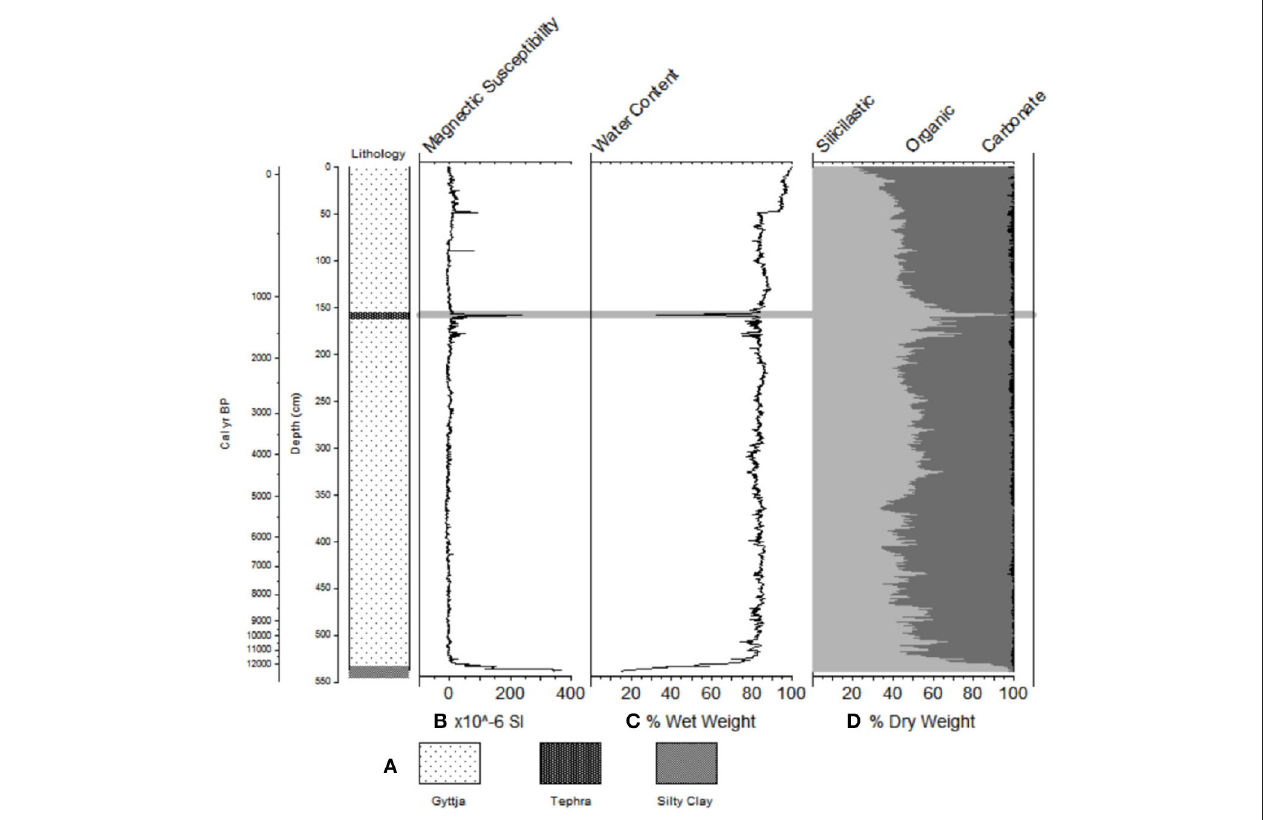
FIGURE 3 | Sedimentology of the sediment record for Spindly Pine Lake, including (A) lithology, (B) magnetic susceptibility, (C) water content, (D) loss-on-ignition. The gray horizontal line represents the tephra deposit. Loss-on-ignition shows the dry weight (%) of organic, carbonate and siliciclastic material.